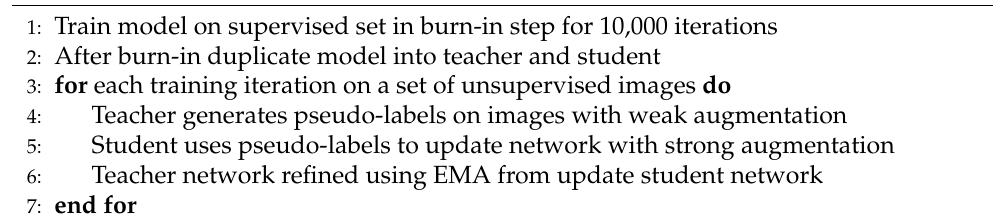
Algorithm 1 : Teacher-student training overview